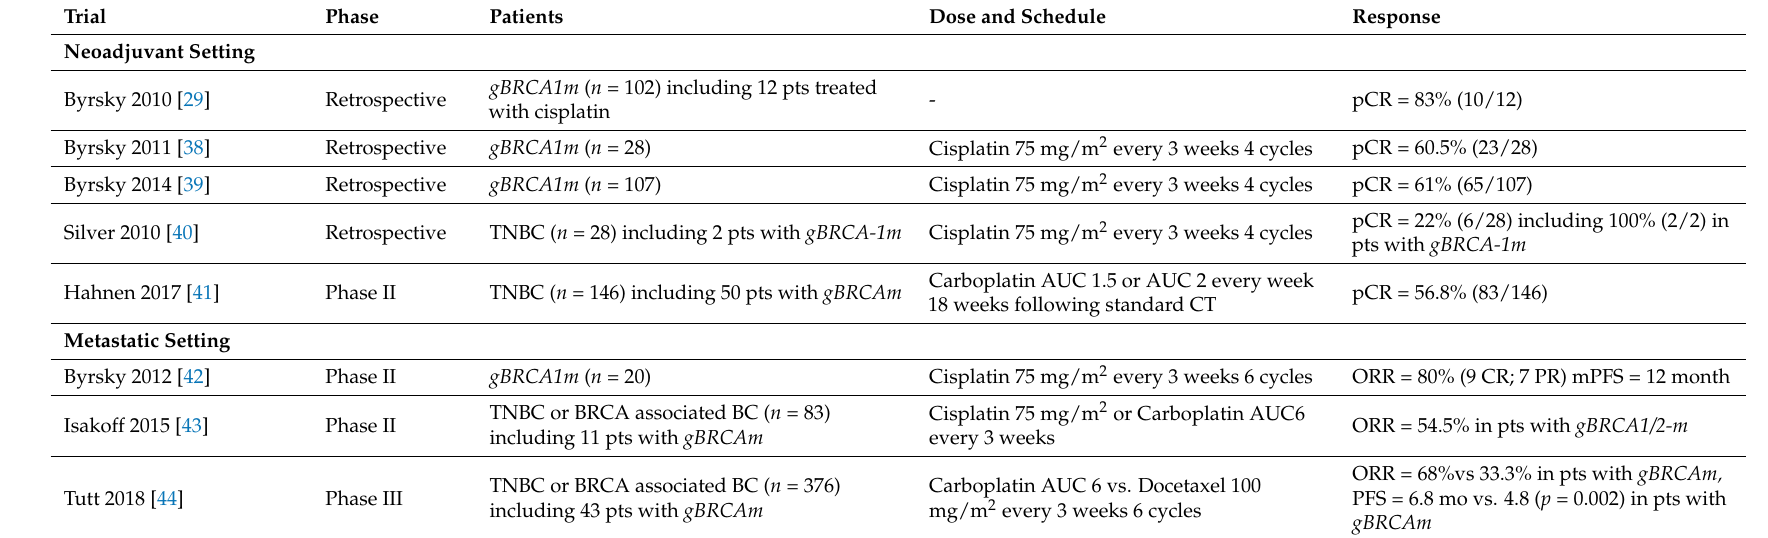
Table 1. BRCA 1/2 -associated Breast cancer and Platinum